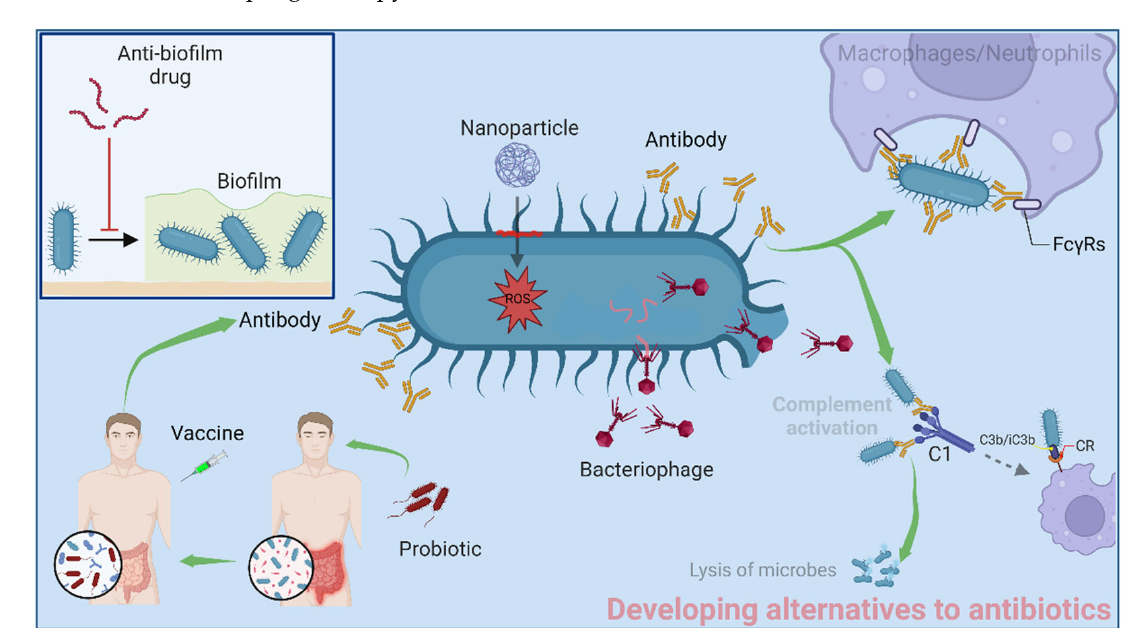
Figure 4. Alternatives to